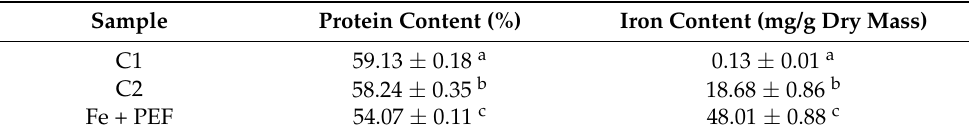
Figure 9. Effect of PEF and iron enrichment on fermentative properties of yeast: C1—control culture without iron added to the medium and PEF treatment, C2—control culture with iron ions added to the medium (200 µ g/mL) and without PEF treatment, Fe + PEF—culture with iron ions added to the medium (200 µ g/mL) and treated with PEF (ferric nitrate, voltage 1500 V, pulse width 10 µ s, treatment time 20 min, 1200 pulses, after 20 h of cultivation). Each value is the mean ± standard deviation ( n = 3). Table 2. Protein content in yeast: C1—without the addition of iron ions and not subjected to PEF; C2—with the addition of iron ions (200 µ g/mL) and not subjected to PEF, Fe + PEF—with the addition of iron ions (200 µ g/mL) and subjected to PEF (ferric nitrate, voltage 1500 V, pulse width 10 µ s, treatment time 20 min, 1200 pulses, after 20 h of cultivation). Each value is the mean ± standard deviation ( n = 3). Means with the same letter (a–c) are not significantly different ( p <